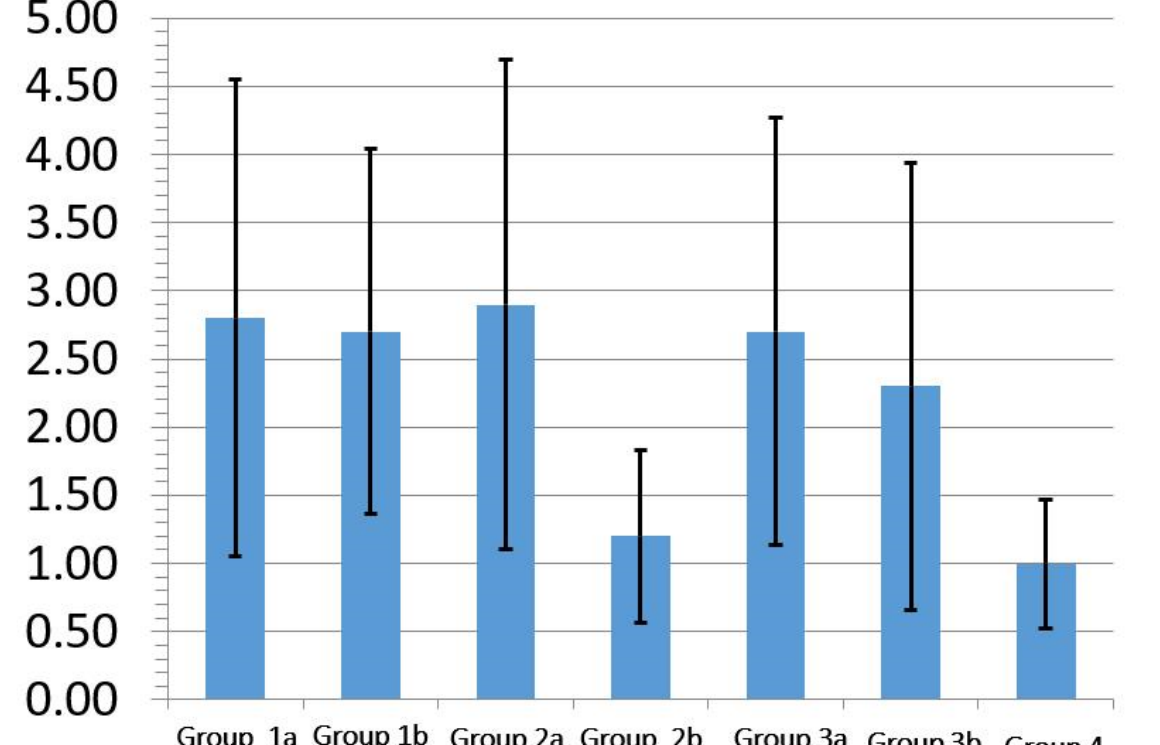
Figure 3. The mean and standard deviation of micro-leakage score for the different tested groups. For each group, the fraction values were obtained from the mean of microleakage scores. Table 3. The mean micro-leakage score for the total-etch (ER) and self-etch (SE) adhesive systems.